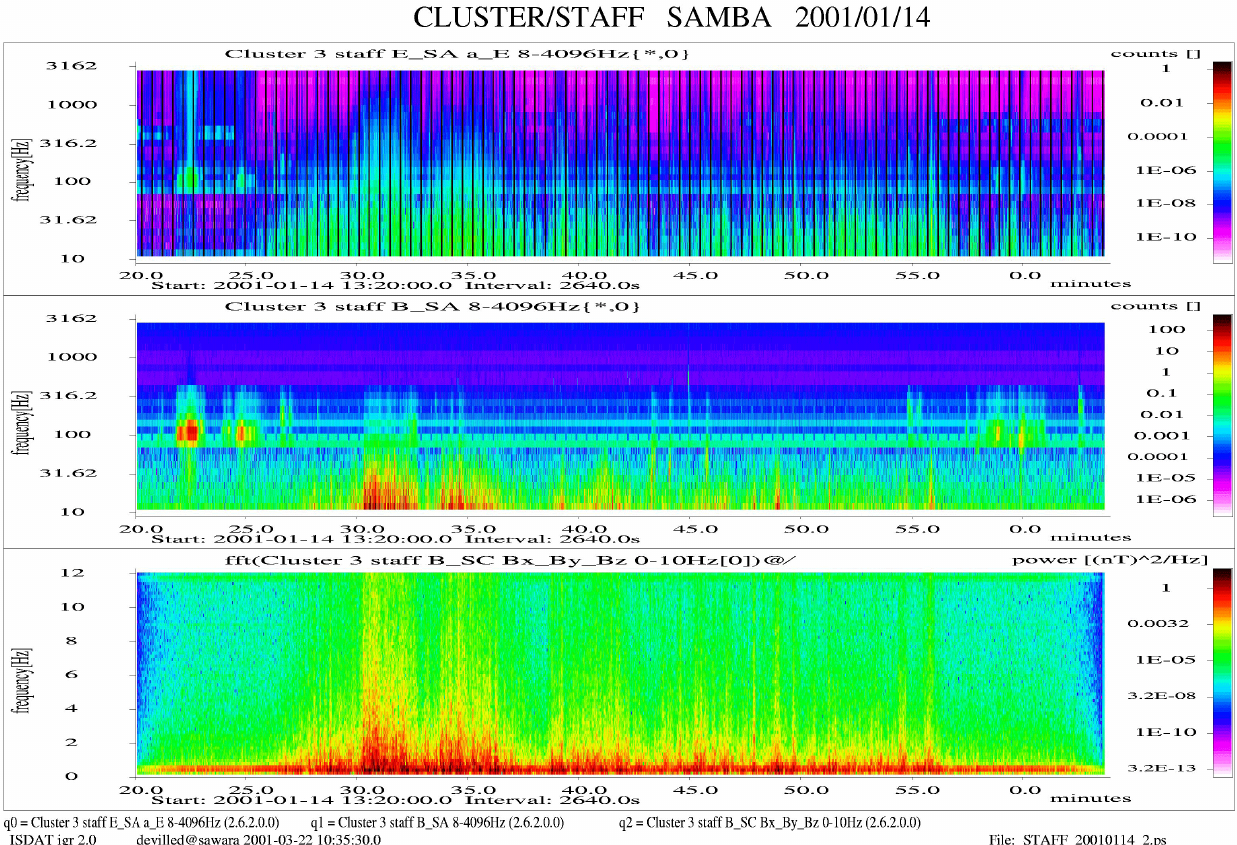
Fig. 22. STAFF spectrograms from 13:20 to 14:00 UT of electric and magnetic field fluctuations in the 8Hz to 4kHz regime (top two panels, respectively) and lower frequency (0–10Hz) magnetic fluctuations (bottom